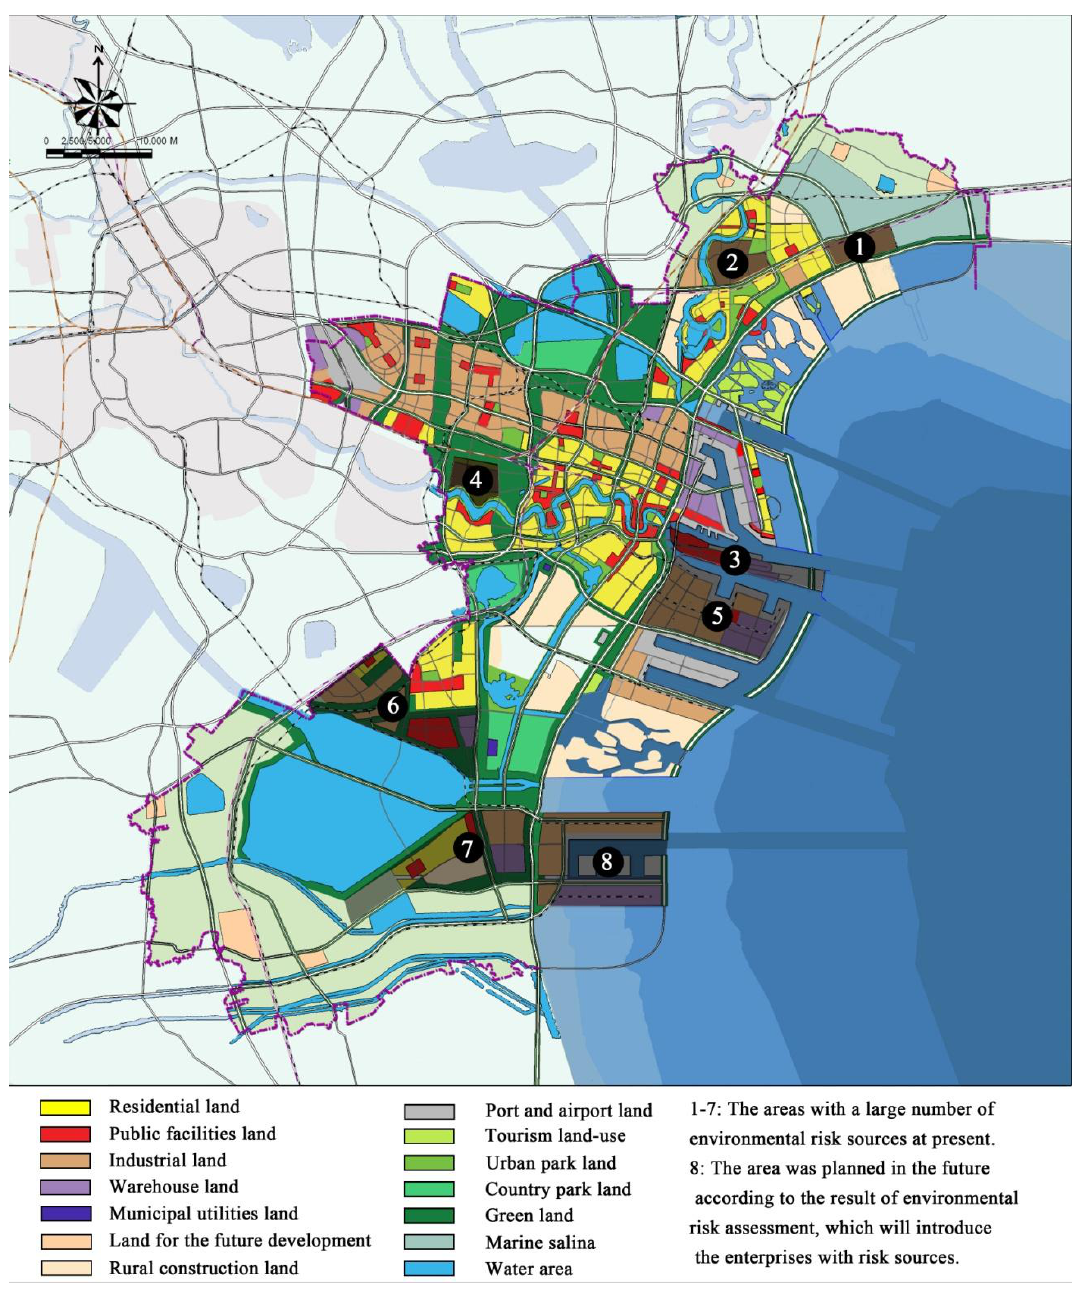
Figure 5. Distribution of the risk sources and the environmental protection goals in Tianjin Binhai New